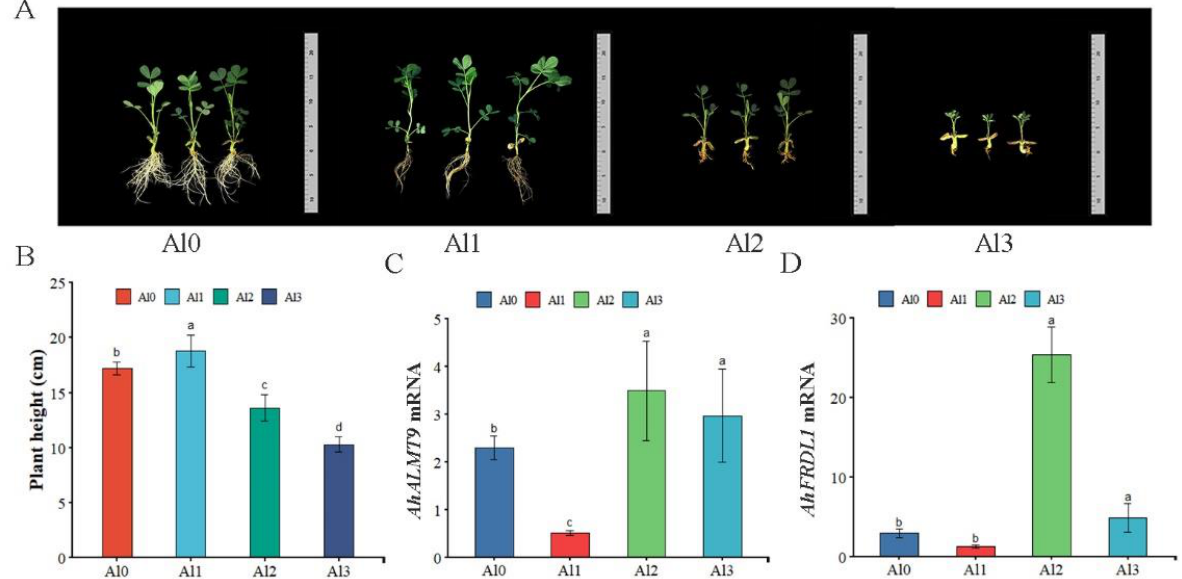
Figure 1. Effects of different concentrations of Al 3+ on the morphological characteristics of peanut and the expression of AhALMT9 and AhFRDL1 genes. Plant height was measured for 14 days of Al treatment ( A ). Effect of different concentrations of Al on peanut plant height ( B ). qRT-PCR analysis of relative transcription levels of AhALMT9 ( C ) and AhFRDL1 ( D ). Al0, Al1, Al2 and Al3 represent 0 (pH 6.85), 1.25 (pH 4.03), 2.5 (pH 3.85) and 5 (pH 3.69) mmol/L AlCl 3 .18H 2 O solutions, respectively. Data are means ( ± SE), n = 3. Marking the same letters means p ≥ 0.05 (LSD), there is no significant difference, the difference between different letters means p < 0.05 (LSD), and the differ- ence is significant.